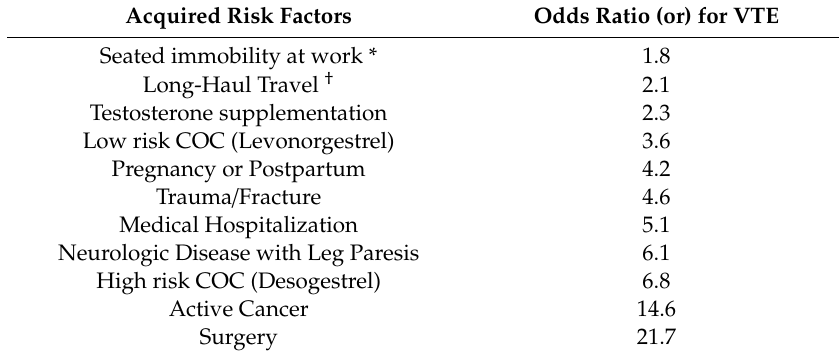
Table 2. Association of Acquired Risk Factors With The Risk of First Episode of VTE [42,76,84–87]. Acquired Risk